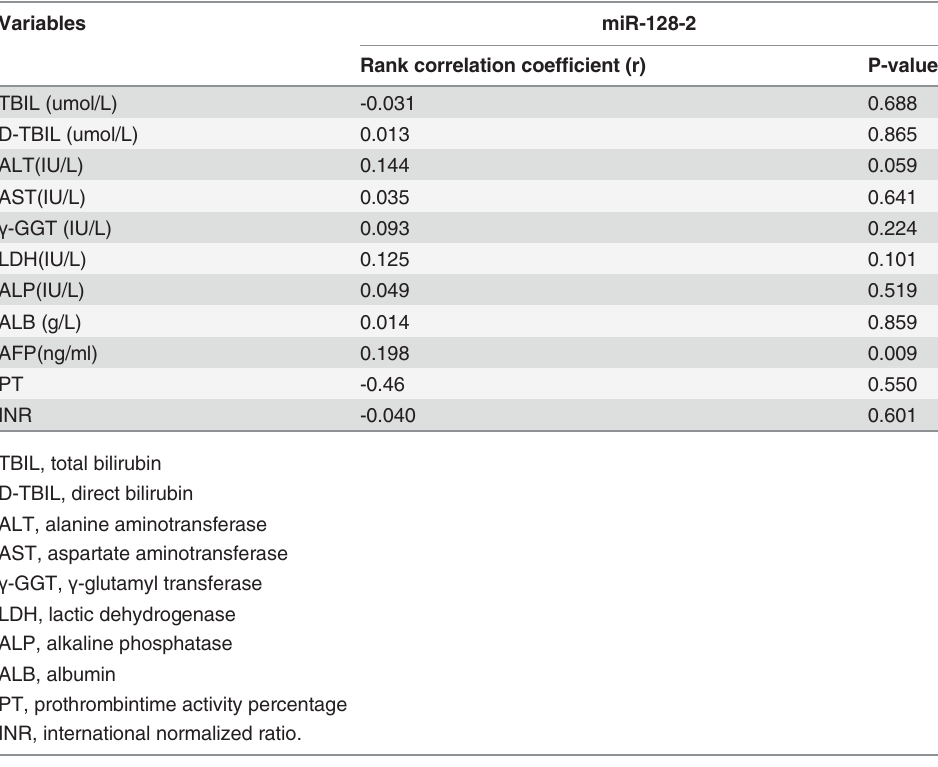
Table 3. Correlation of serum miR-128-2 levels and laboratory